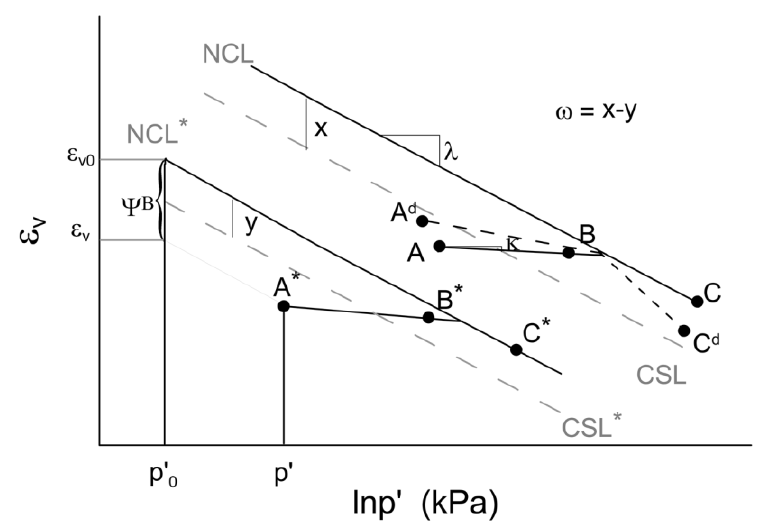
Figure 4. Concept of the additional structure parameter 𝜔 in the S_BRICK model [16].